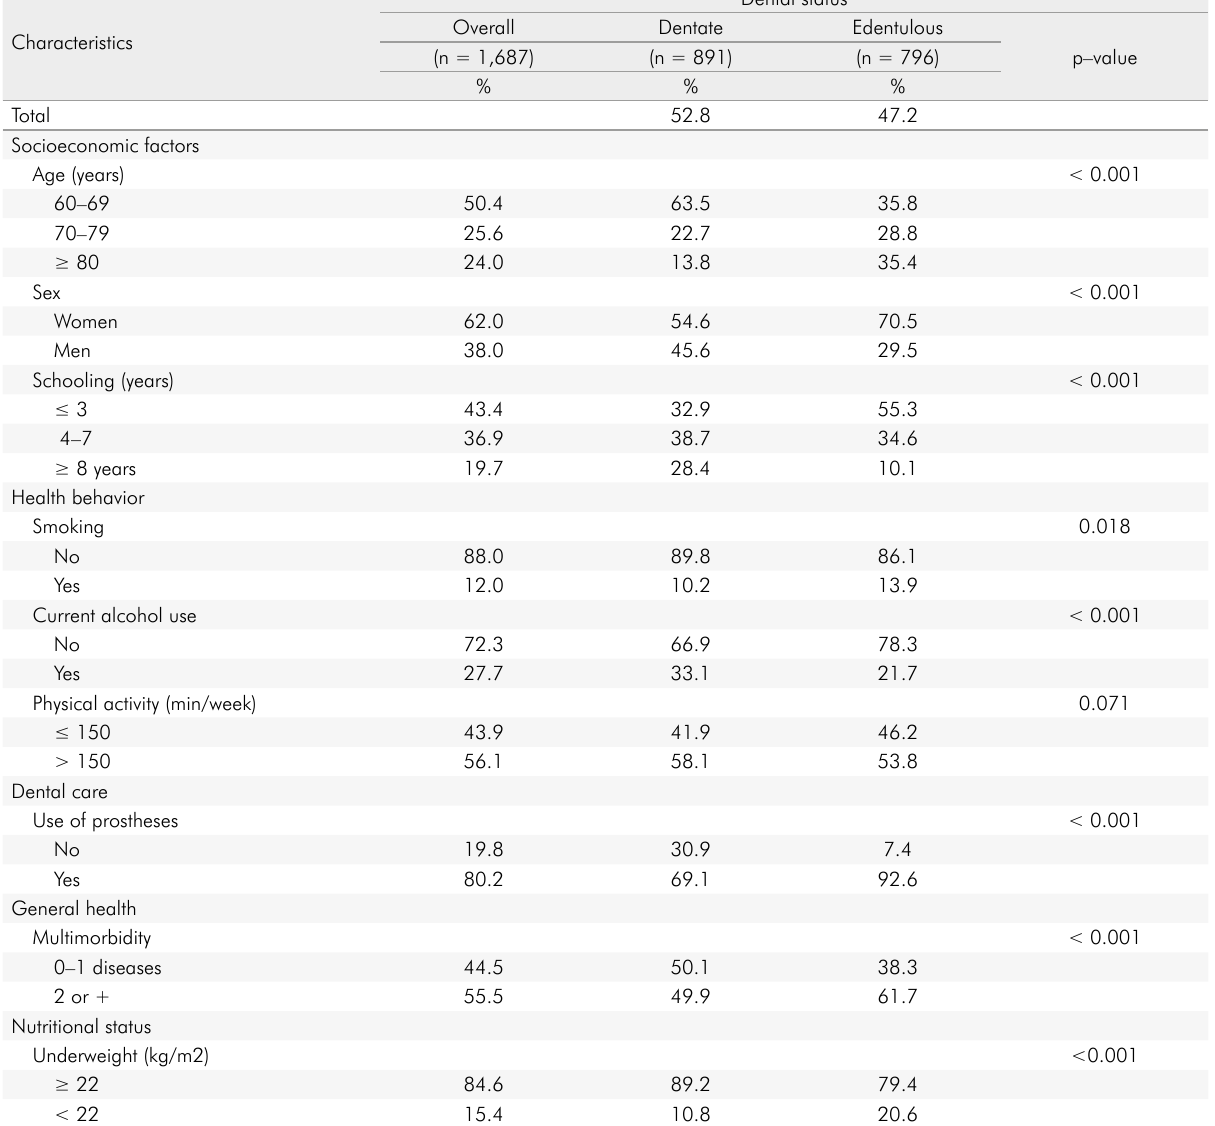
Table 1. Baseline characteristics according to edentulism status among Brazilian older adults.